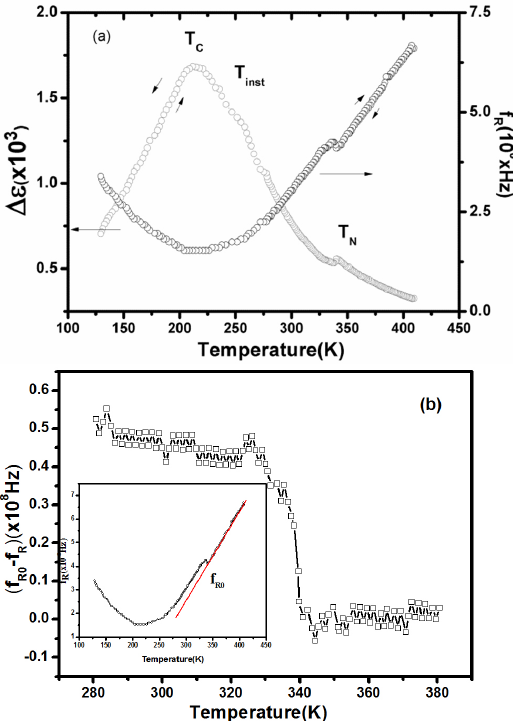
Figure 4. (a) Dielectric susceptibility at 80MHz and (b) dependence of the characteristic frequency (fR0 - fR) change versus temperature for PFW ceramics.